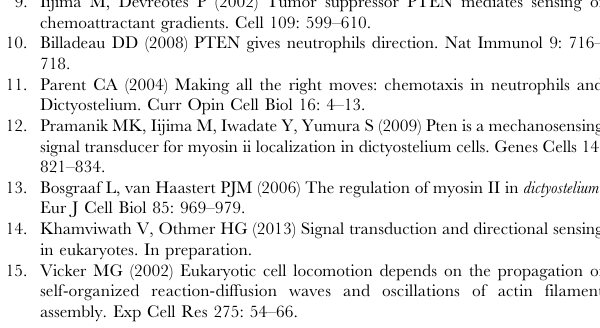
Figure S1 Separation of wave covered regions and formation of new wave fronts. Dynamics of actin waves, represented by concentration of filament pointed ends, is depicted as PTEN intrusion in a narrow region at t ~ 25 s causes depletion of the F-actin and formation of new wave fronts at locations adjacent to the